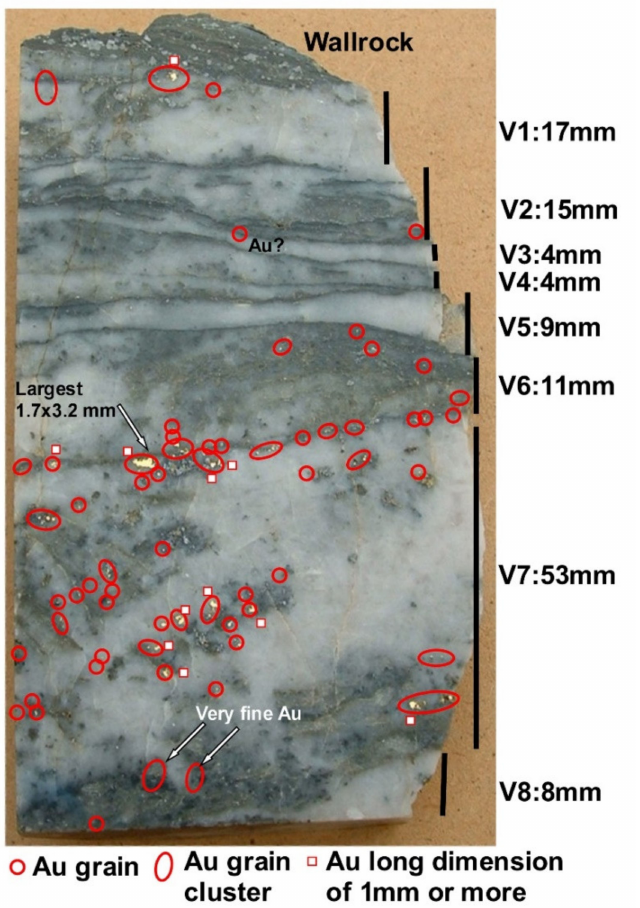
Figure 9. Sample B5 illustrating features of vein assemblage, mudstone-arsenopyrite screens and distribution of visible gold in laminated reef. V1 shows arsenopyrite-gold assemblage associated with mudstone flakes. V2–V5 shows very narrow veins with minor arsenopyrite with only gold near V2/3 boundary. V7 shows a major gold pocket. Estimated sample grade 4200 g/t Au from